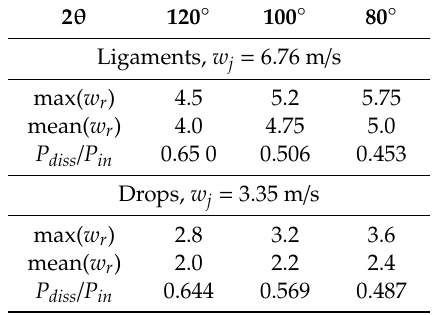
Table 1. Influence of the angle between the jets 2 θ on the maximum (max( w r )) and average (mean( w r )) velocity of the ligaments (data determined from the graphs in [26]) as well as the fraction of dissipated energy P diss / P in ( d j = 1 mm). 2